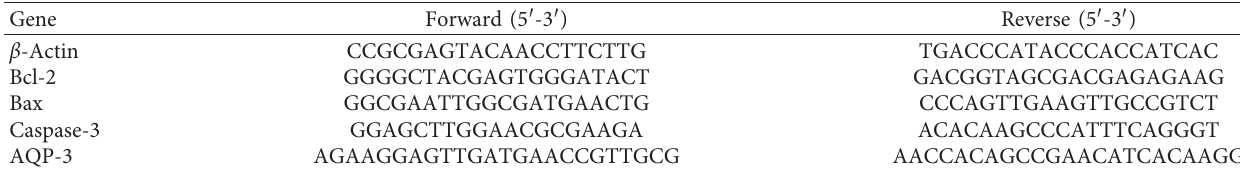
Table 1: Primers of target